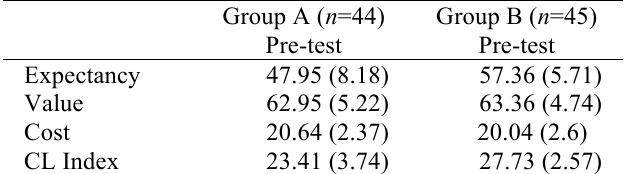
Descriptive Statistics of pre-test for groups A and B. Mean (Standard